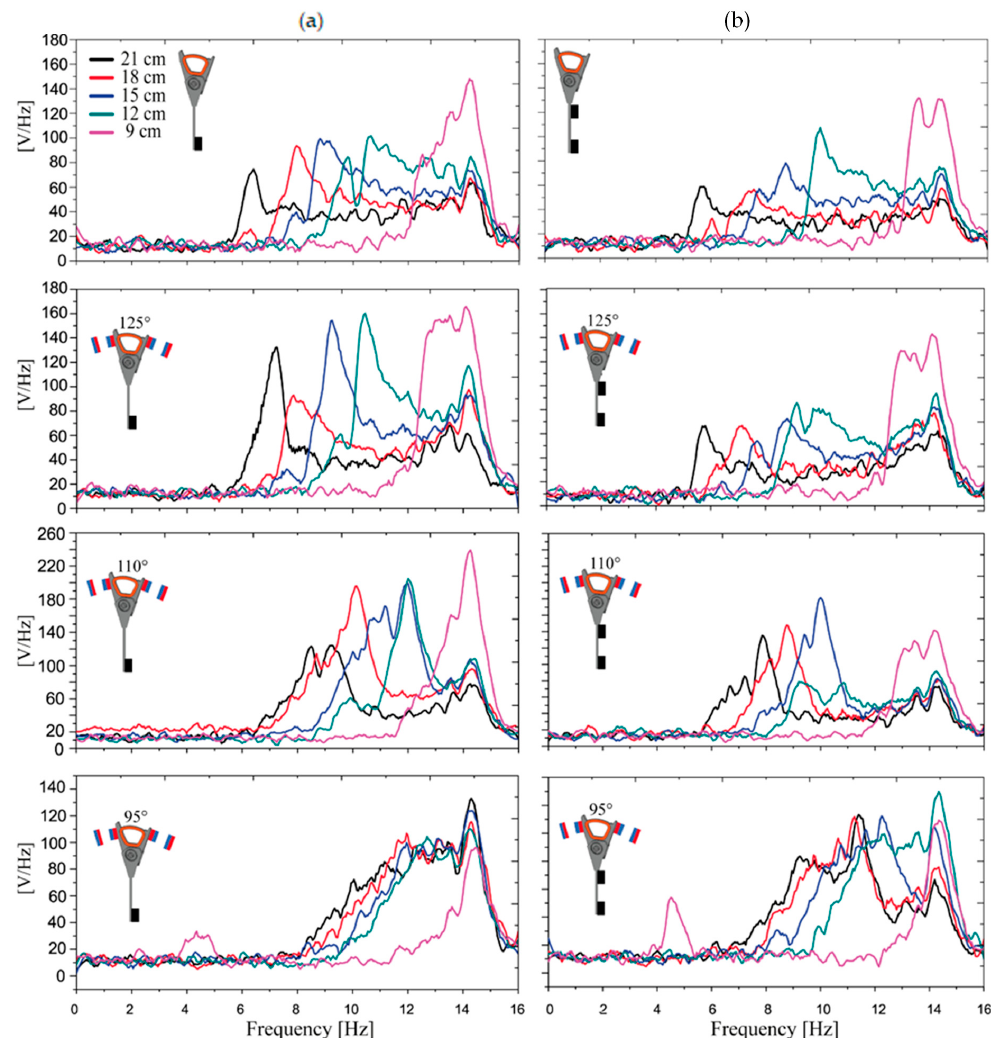
Figure 6. Frequency response functions for experiments I and II. Column ( a ) represents experiments with one mass for inductive mode and magnets located to 125 °, 110 °, and 95 °. Column ( b ) represents the experiments with two masses.